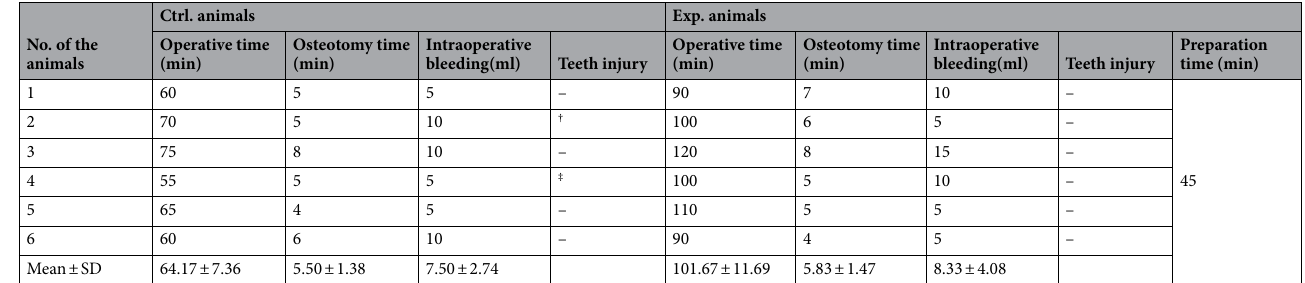
Table 2. Safety and preparation assessment. † Osteotomy line cutting the molar. ‡ One screw damaging the dental root during the distraction device